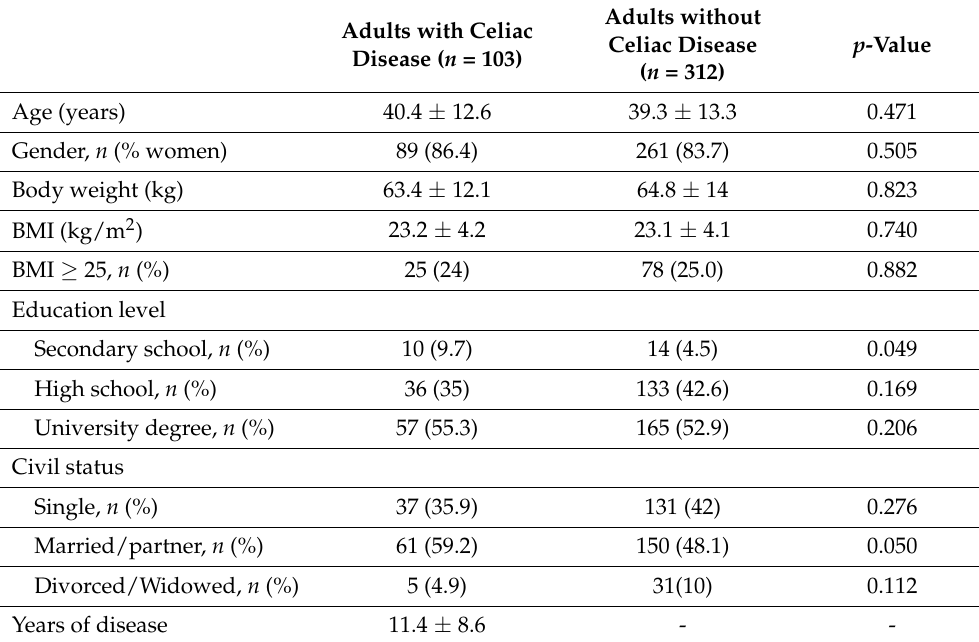
Table 1. Sociodemographic characteristics of the study population.